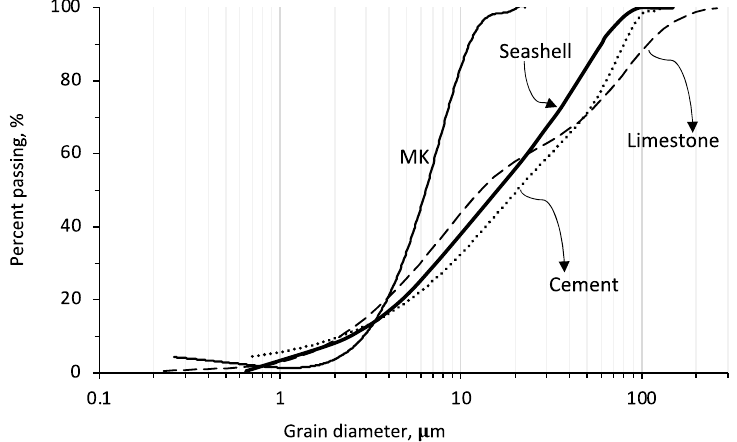
Figure 2. Particle size distribution curves for materials used.